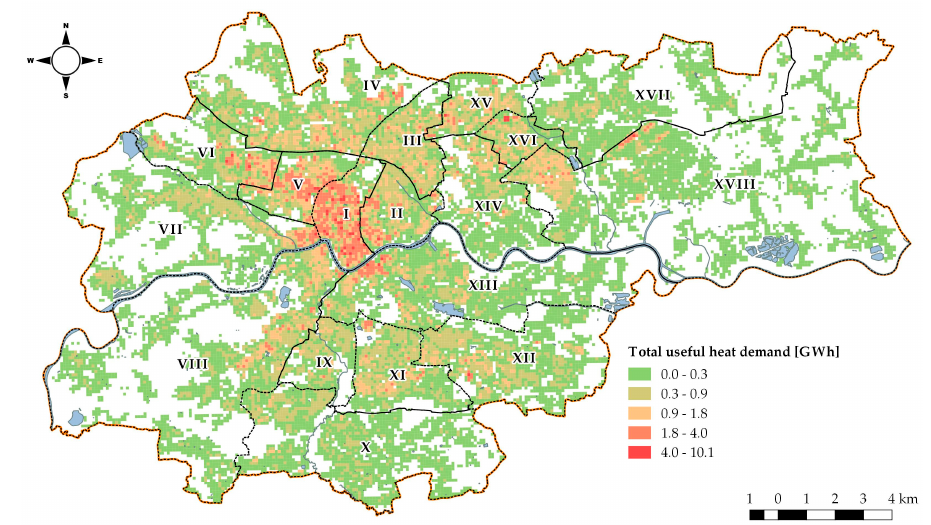
Figure 2. Annual total useful heat demand in GWh per one hectare.